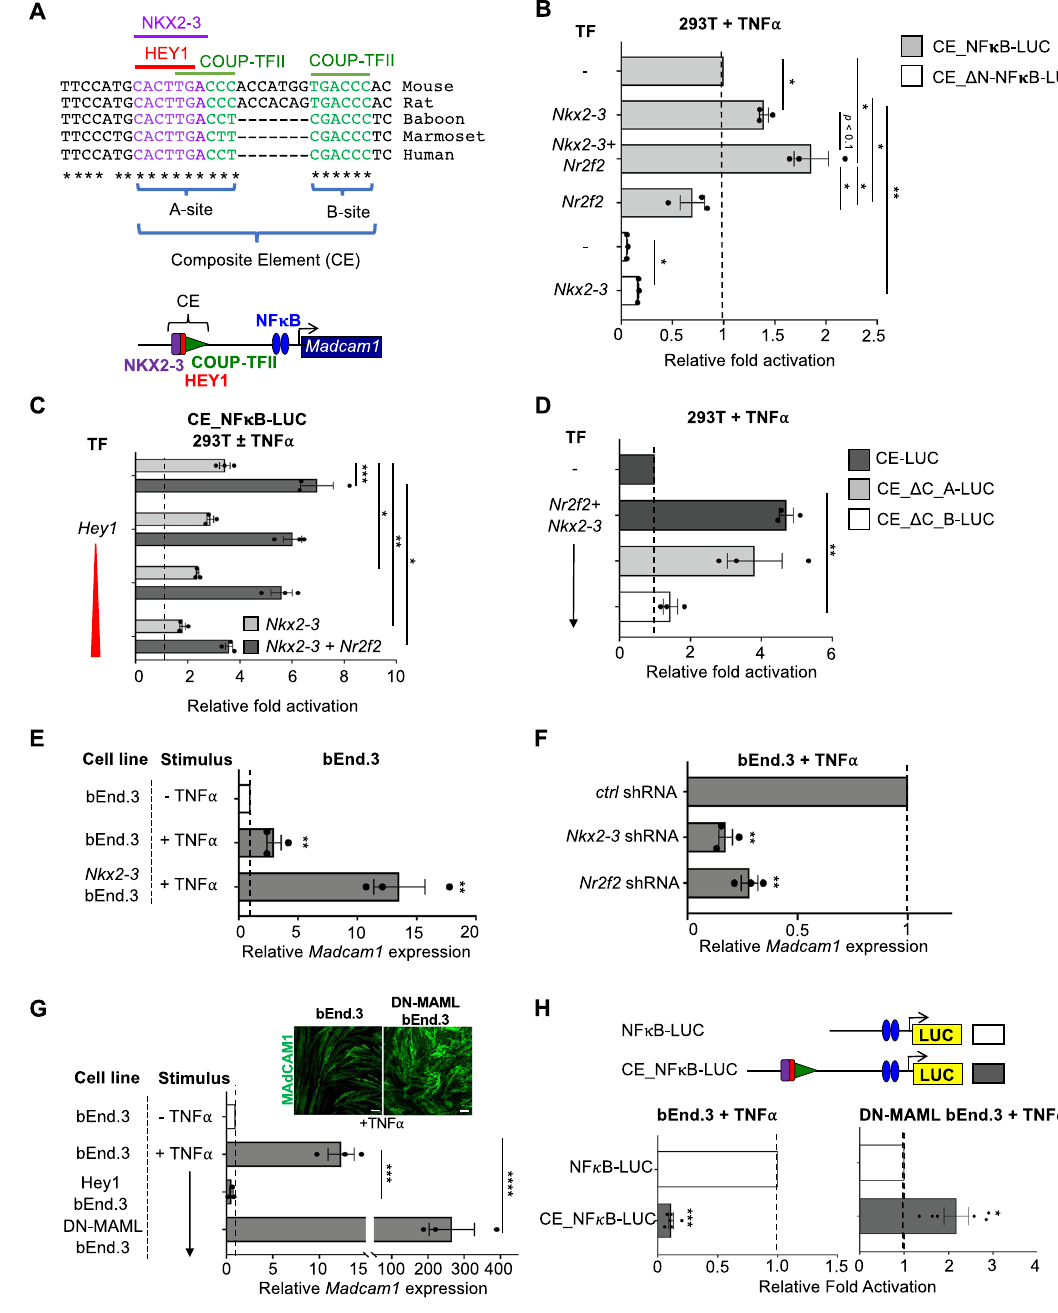
Fig. 1 | An evolutionarily conserved composite element (CE) in the Madcam1 promoter integrates NKX2-3, COUP-TFII, and HEY1 to regulate transcription. A Sequence of the CE in indicated species, and schematic of the CE. Conserved E-box (HEY1 binding site), homeodomain (NKX2-3 binding site) and COUP-TFII binding sites are highlighted in red, purple and green respectively. B Nkx2-3 or cooperative Nkx2-3 and Nr2f2 enhanceTNF α stimulated luciferasereporteractivity drivenbyCE-containing Madcam1 promoter(CE_NF κ B-LUC)in293Tcells.Mutation of the homeodomain motif(inCE_ Δ N-NF κ B-LUC)inhibitsactivity.Datanormalized to CE_NF κ B-LUC activity. C HEY1 dose-dependently suppresses Nkx2-3 (light gray bars) or cooperative Nr2f2 and Nkx2-3 (dark gray bars) transcriptional activation from the CE-containing Madcam1 promoter in TNF α stimulated 293T cells. Data normalized to basal reporter activity without TNF α stimulation (dashed line). D Effects of mutation of COUP-TFII “ A ” (CE_ Δ C_A-LUC) or “ B ” (CE_ Δ C_B-LUC) sites on cooperative Nr2f2 and Nkx2-3 activation of luciferase reporter in 293T cells. ResultswerenormalizedtocontrolCE-containingreporteractivity.Vectorcontains threetandemcopiesofCE. E Inductionof Madcam1 expressioninTNF α stimulated